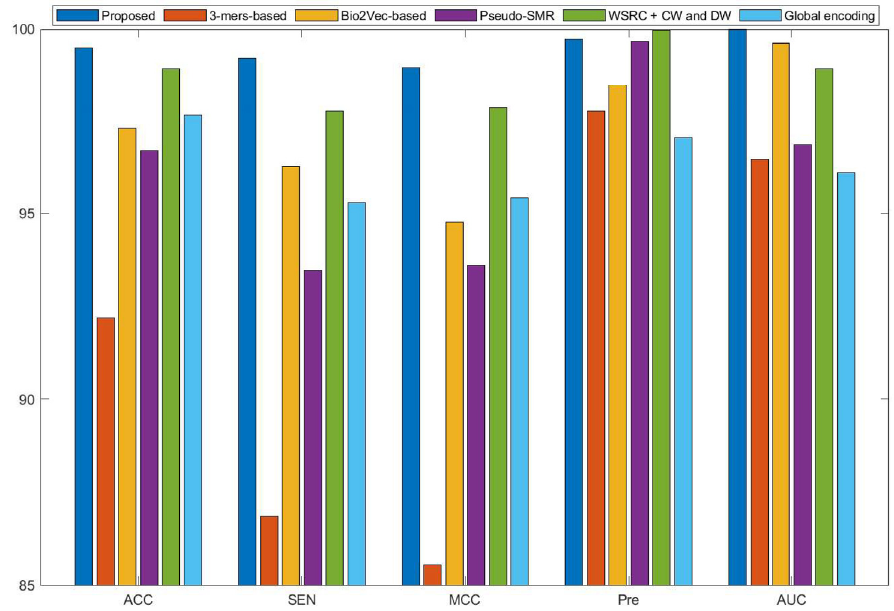
Figure 2. Comparison results of different methods on the human data set.